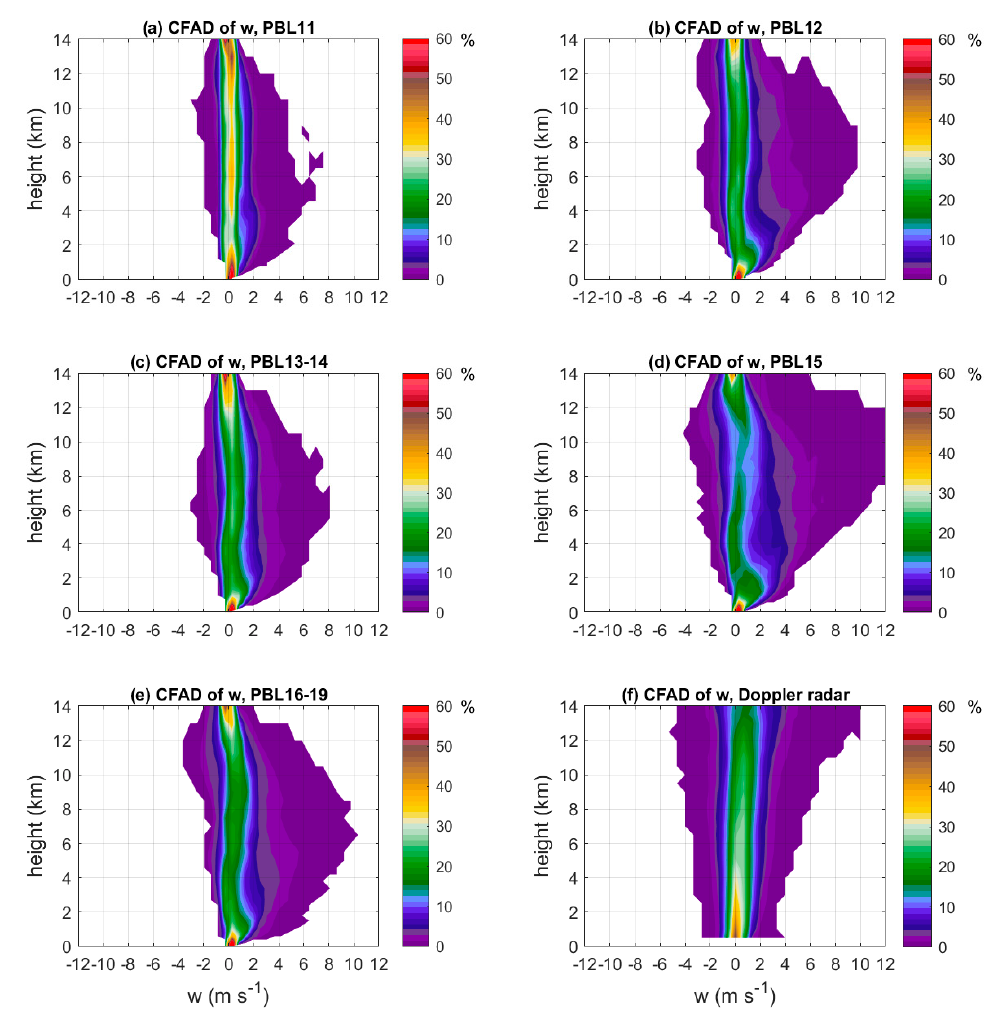
Figure 14. Contoured Frequency by Altitude Diagrams (CFADs) of vertical velocity ( w ) in the eyewall region (0.75 < r / RMW < 1.25) during the rapid intensification period (12–30 h) in the idealized HWRF simulations with ( a ) PBL11, ( b ) PBL12, ( c ) PBL13–14, ( d ) PBL15, and ( e ) PBL16–19 schemes. CFAD of w from Doppler radar observations is shown in ( f ).